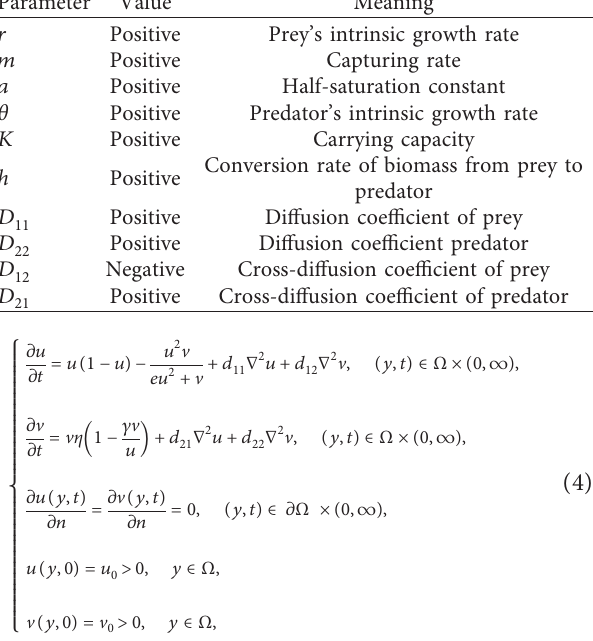
Table 1: The meaning of parameters in model (3).